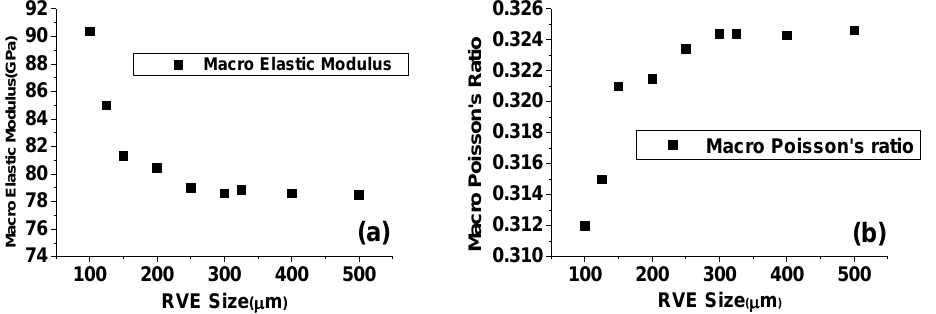
Figure 8. Convergence of ( a ) macro elastic modulus and ( b ) Poisson’s ratio.